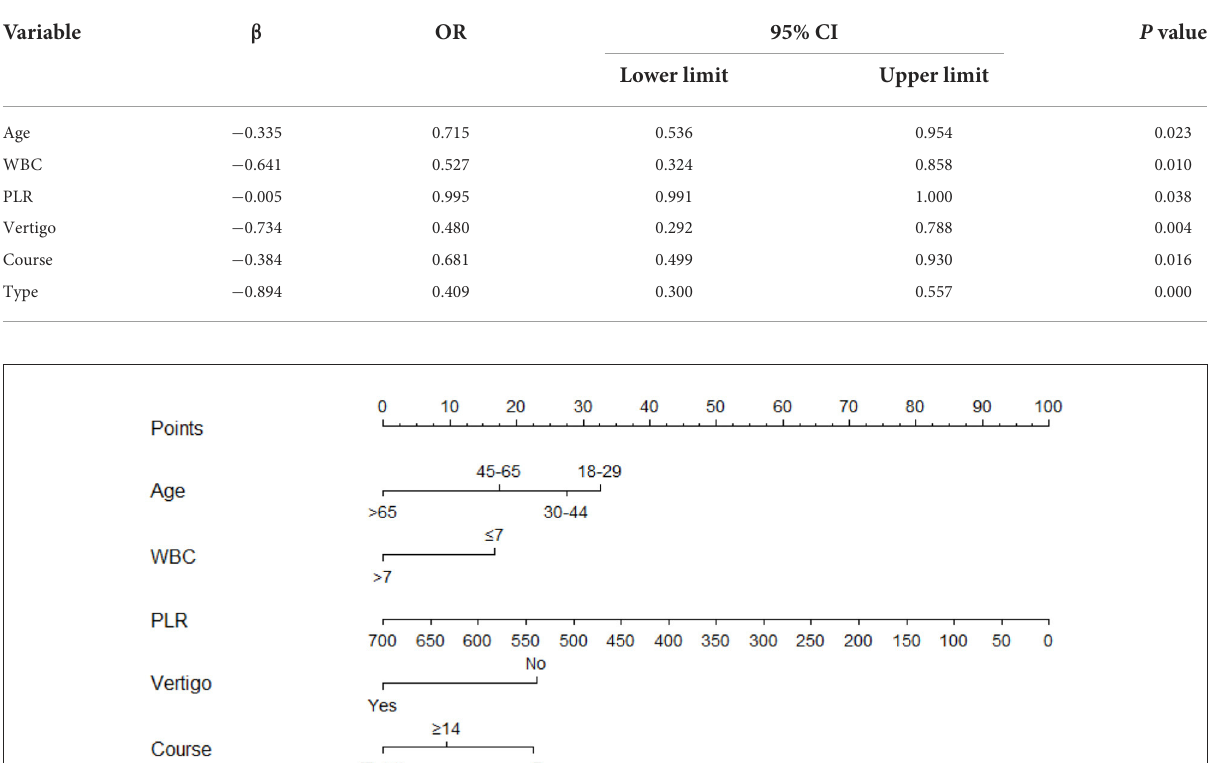
TABLE 3 Multivariate logistic regression analysis of treatment